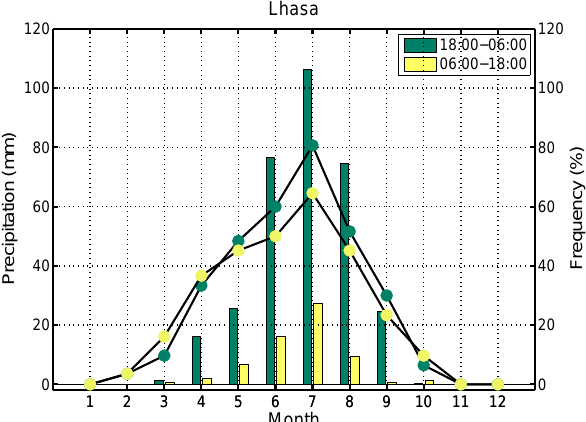
Figure 2. Precipitation (bars) in the daytime (06:00–18:00LT) and at night (18:00–06:00LT) from June 2012 to May 2013 in Lhasa. The frequency of precipitation in each month is shown by